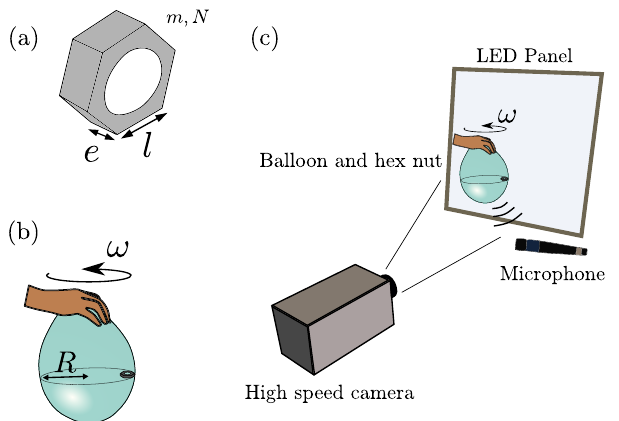
Fig. 1. Experimental setup and nomenclature. (a) Sketch of the hex nuts used in experiments. A nut is characterised by its number of sides N , it’s side length l , its width e and its mass m , (b) Close sketch of the balloon, characterised by its radius R and its rotating speed ω . (c) Sketch of the experimental setup.